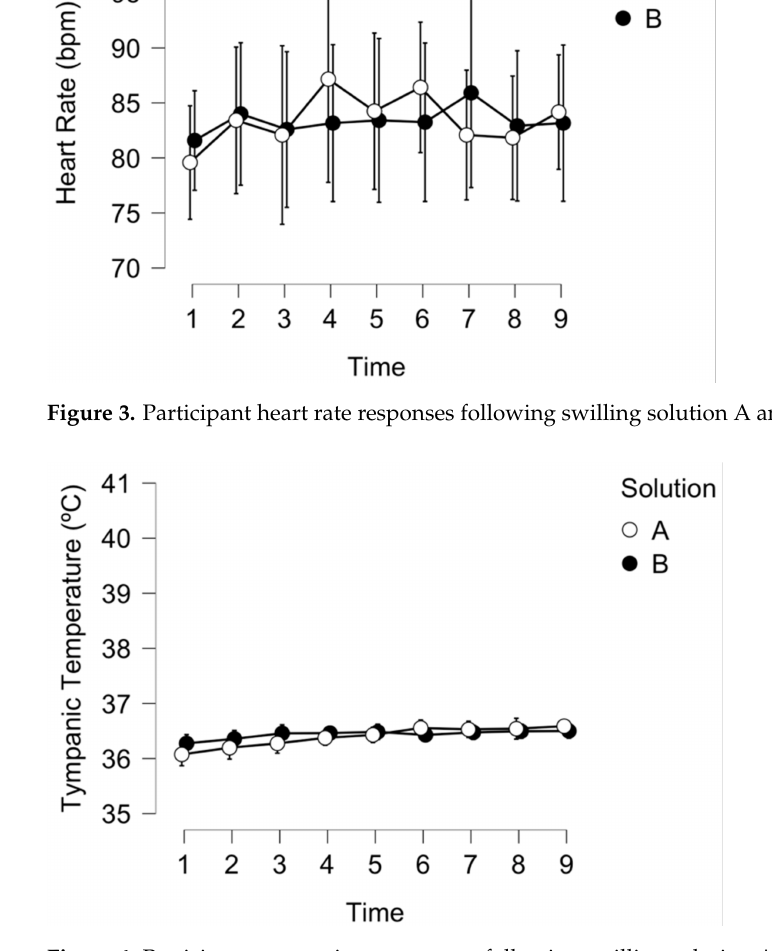
Figure 4. Participant tympanic temperature following swilling solution A and